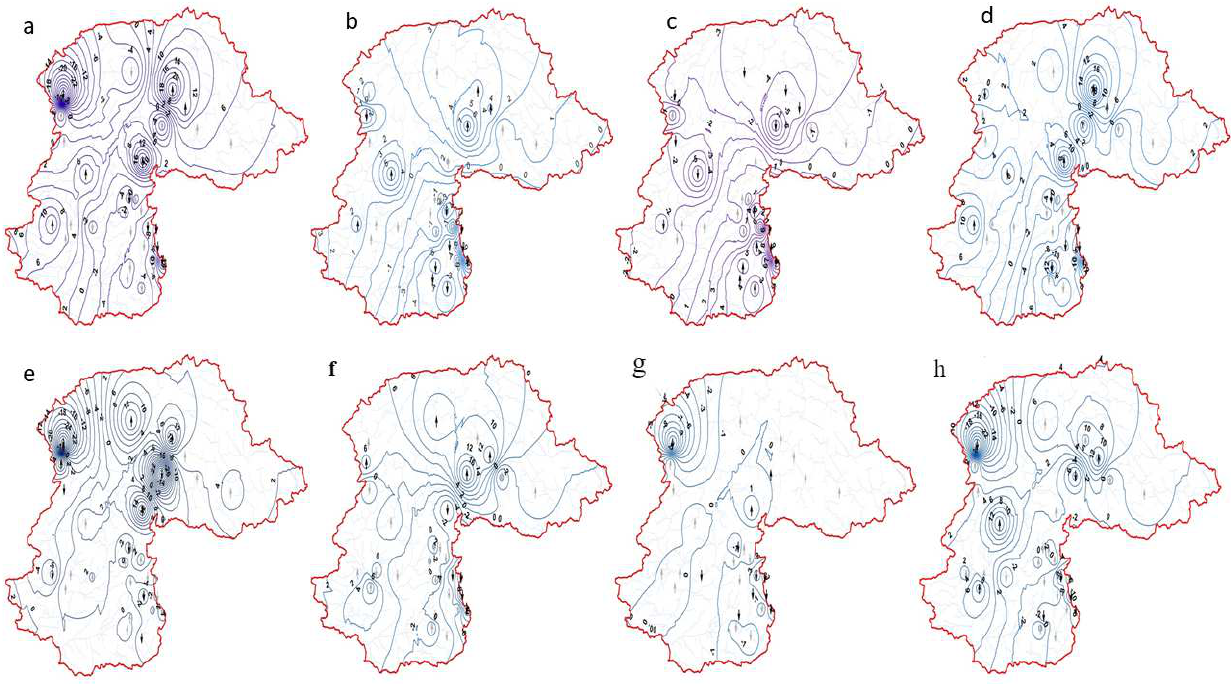
Figure 6. Change in precipitation extreme indices: ( a ) Rm, ( b ) WD, ( c ) CDD, ( d ) Rsum, ( e ) SDII, ( f ) Rx, ( g ) R25, and ( h ) R5day.